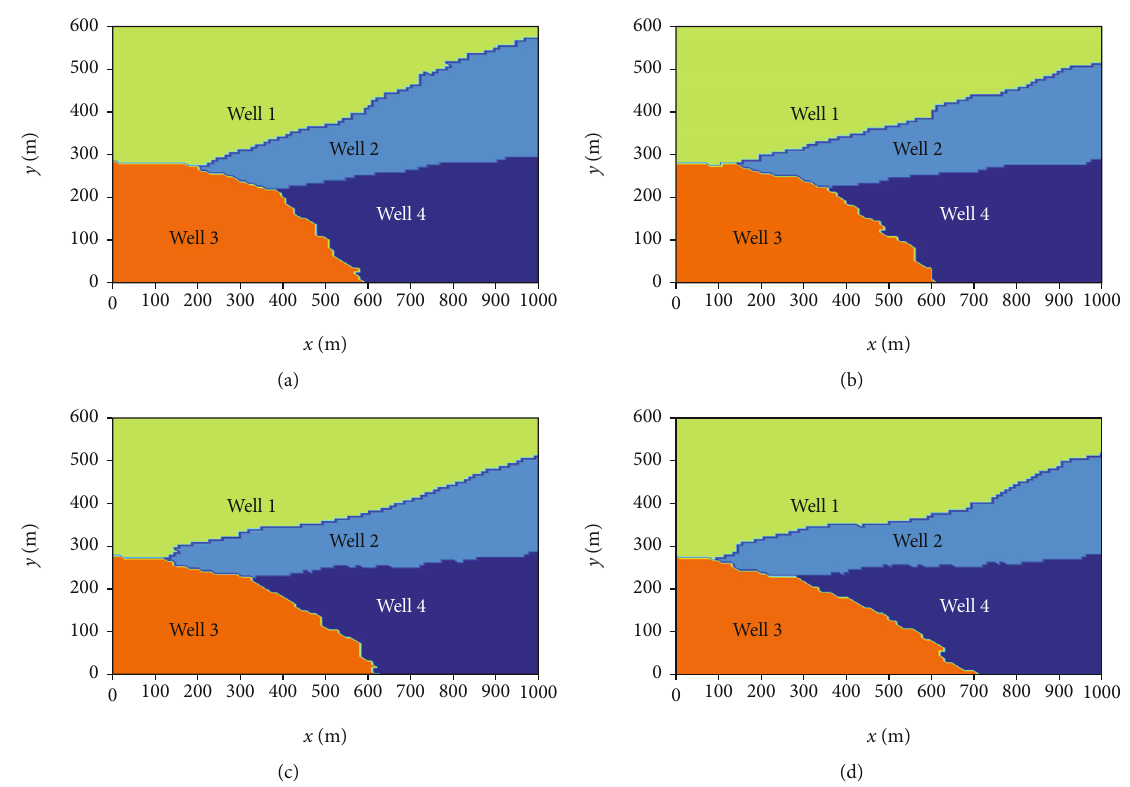
Figure 11: Geometries of the control volumes of the production wells with di ff erent fracture lengths.